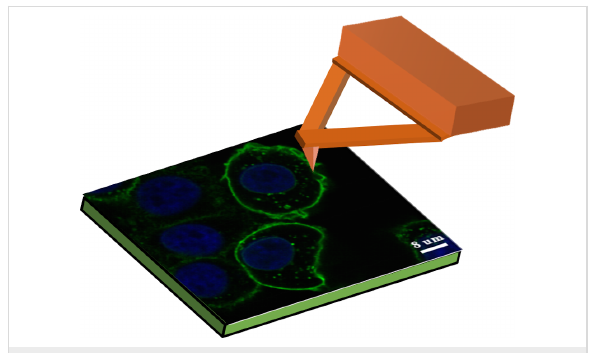
Figure 1: Schematic image of the pancreatic cell characterized by AFM.